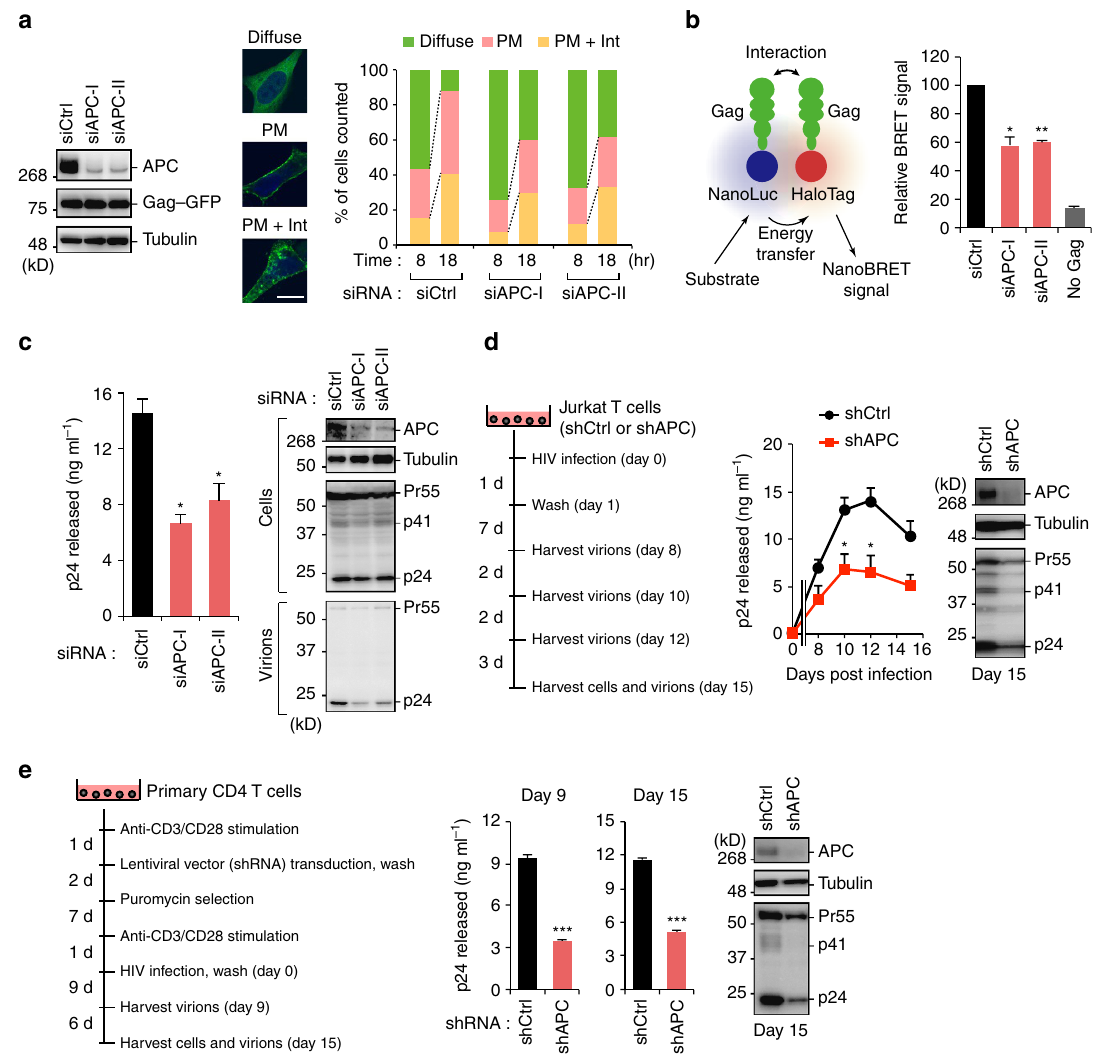
Figure 5 | APC regulates the recruitment of Gag to the PM. ( a ) HeLa cells were treated with control siRNA (siCtrl) or two different sequences of APC-targeted siRNAs (siAPC-I or -II) for 24h before transfection with Gag–GFP expression vector. Blots show the detection of APC, tubulin and Gag–GFP by immunoblotting. At 8 and 18h after transfection, over 100 cells were analysed for the subcellular localization of Gag–GFP, which was either strongly evident at the plasma membrane only (PM), at the PM and intracellular accumulations (PM þ Int), or diffusely in the cytoplasm (diffuse). The data are percentages of the total cells. Scale bar, 10 m m. ( b ) HeLa cells were transduced with control siRNA (siCtrl) or two different sequences of APC-targeted siRNAs (siAPC-I or -II) for 24h before co-transfection with Gag-HaloTag and Gag-NanoLuc expression vectors. At 48h after transfection, NanoBRET signals were measured. ( c ) HCT116 cells were treated with either siCtrl or APC-targeted siRNAs (siAPC-I or -II) for 24h before transfection with pNL4-3. At 48h after transfection, culture supernatants and cell lysates were analysed by p24 enzyme-linked immunosorbent assay (ELISA) and immunoblotting, respectively. ( d , e ) Multi-cycle viral replication analysis of Jurkat cells ( d ) or primary CD4 þ T cells ( e ) stably expressing control shRNA (shCtrl) or APC-targeted shRNA (shAPC). Cells were infected with HIV-1 NL4-3 . Cell supernatants were collected at the indicated time points and subjected to p24 ELISA. The expression of APC and Gag in each cell is also shown. All graphs are presented as a mean ± s.d. ( n ¼ 3). * P o 0.05, ** P o 0.01, *** P o 0.001, two-tailed unpaired t -test. Full images for all immunoblots are provided in Supplementary Fig.